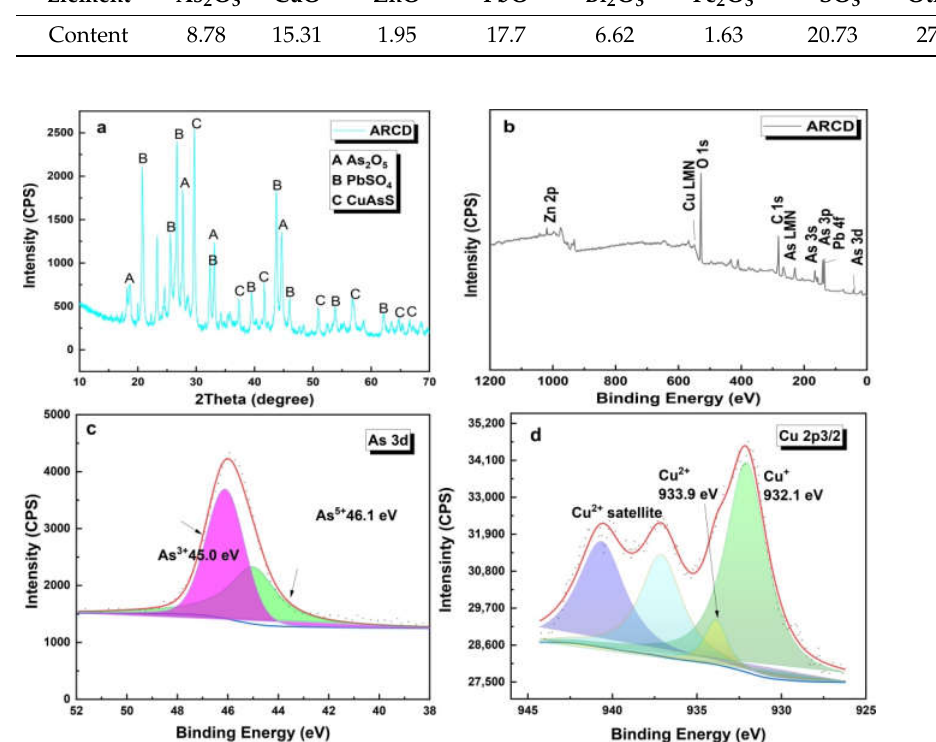
Table 1. The main compositions of the ARCD (* Data from XRF and other data from ICP, wt.%).